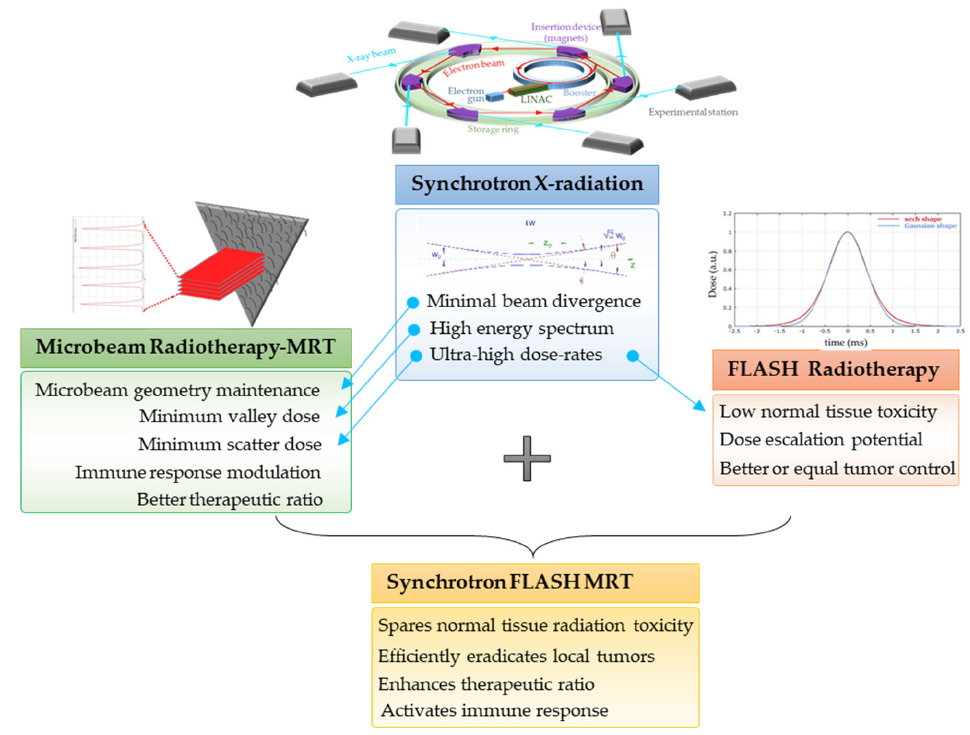
Figure 2. Synchrotron X-ray radiation properties are essential for both MRT and FLASH RT. Syn- chrotron MRT in FLASH mode is the combinatorial result of MRT and FLASH RT, whose properties dictate its therapeutic potential.